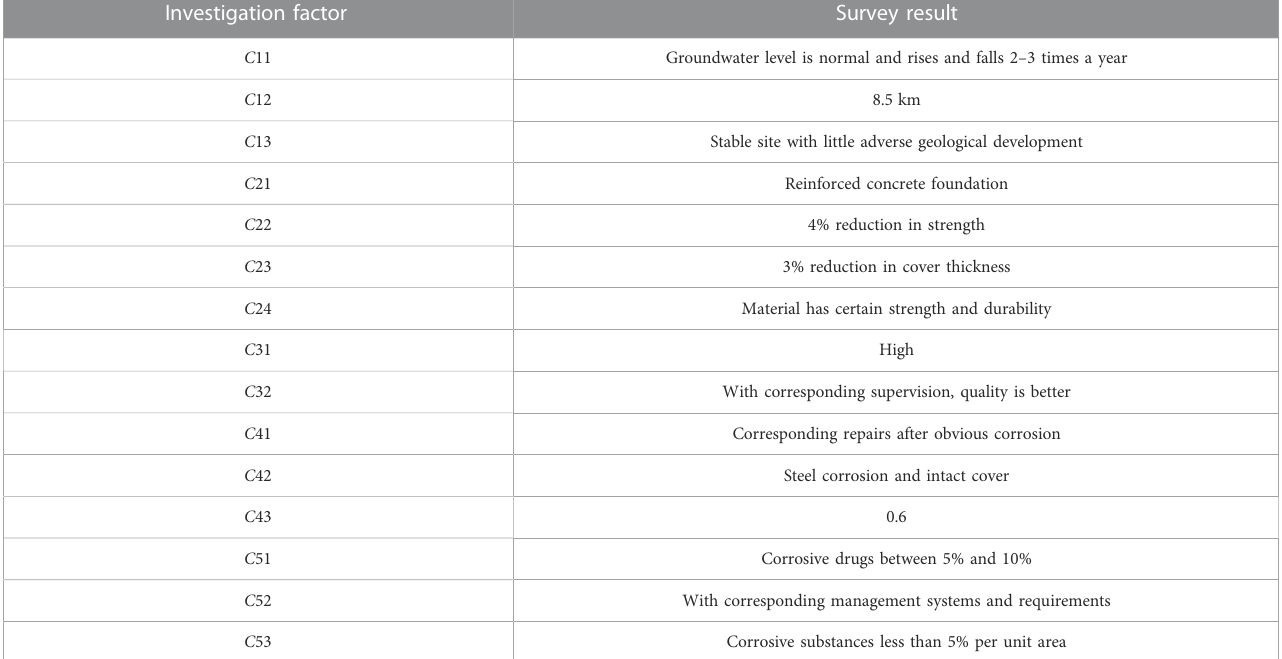
TABLE 6 Survey results of building structure parameters based on the index